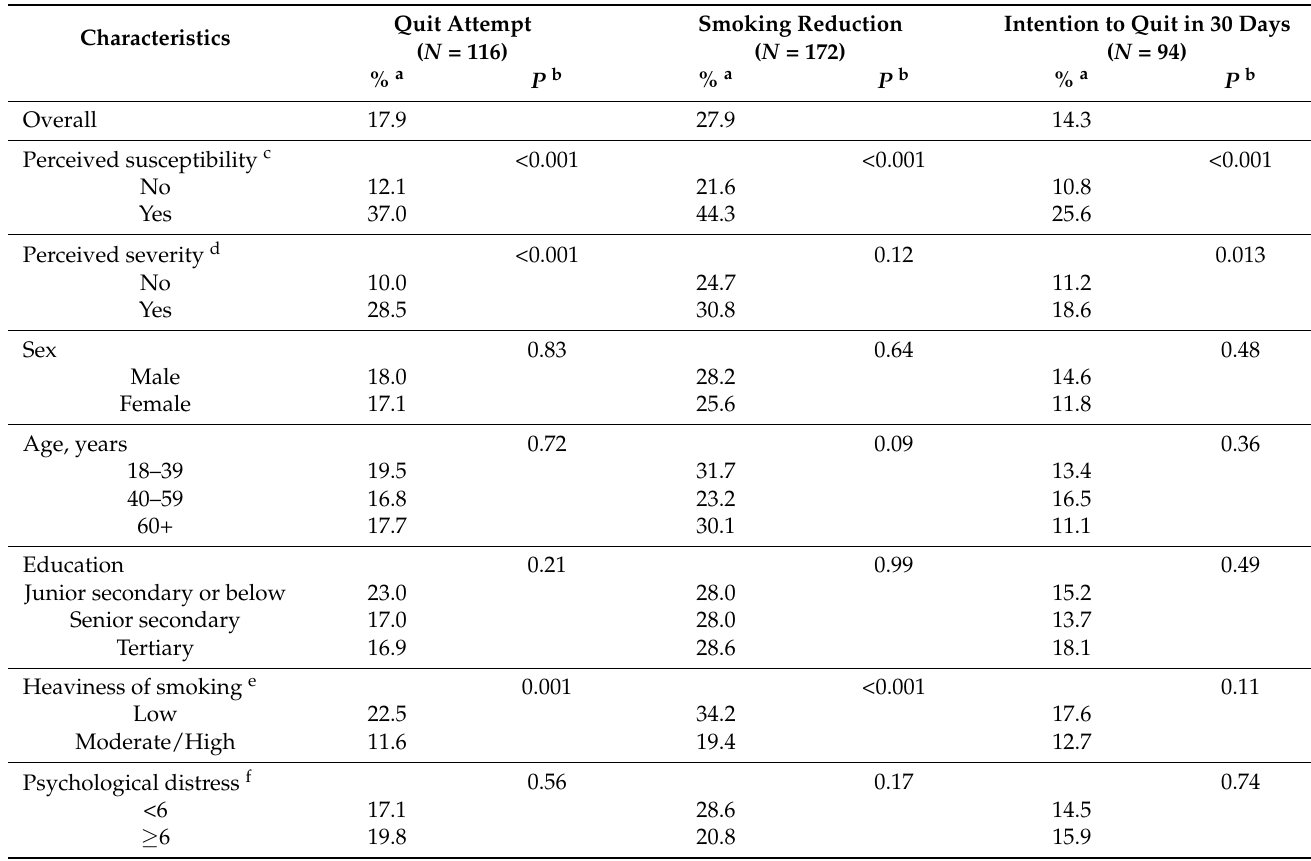
Table 2. Prevalence of high perceived susceptibility and severity of COVID-19 in relation to smoking according to participants’ characteristics.